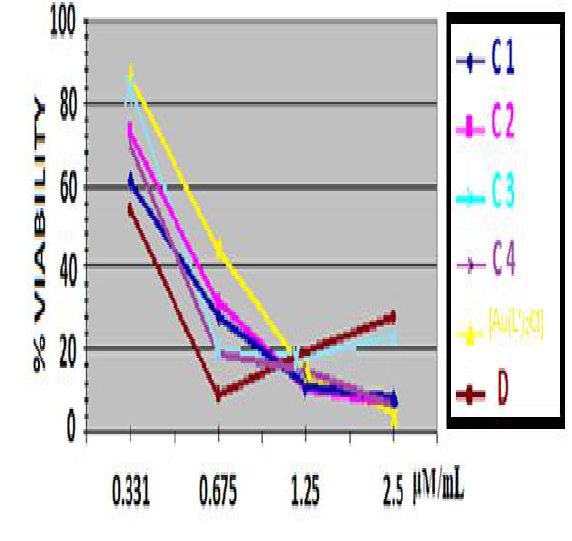
Figure (3) : Comparative cytotoxicities (% viability)of the synthesized complexes (( Au( L' ) Cl)).(C1-C4) with cisplatin 2 (positive control) It may be ruled out that there is no correlation between different arrangement of ligands (L) and (L') whether monodentate or bidentate, planar or pentacyclic , and neutral or charged around central metal,. Such a finding allows us to state that the presence of H in sulfur-donor ligand is not an essential requirement for cytotoxicity in gold (III) complexes, i.e. to pharmacodynemic (16)